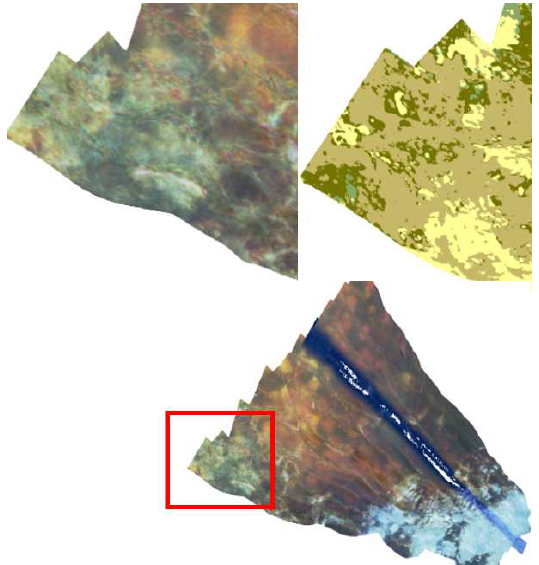
Figure 5: Indicative misclassification cases at Bedford Basin 2016 as identified during the qualitative evaluation assessment.